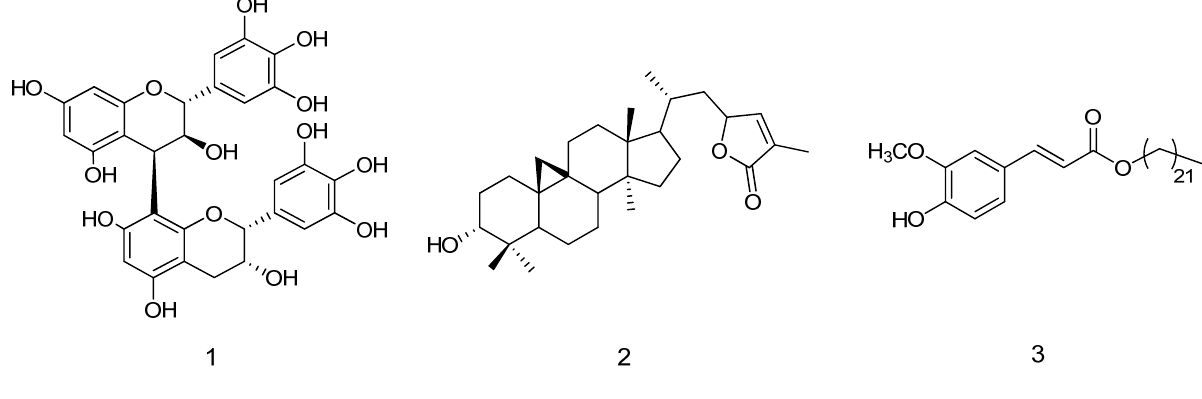
Figure 3. Chemical structures of compounds isolated from the bark